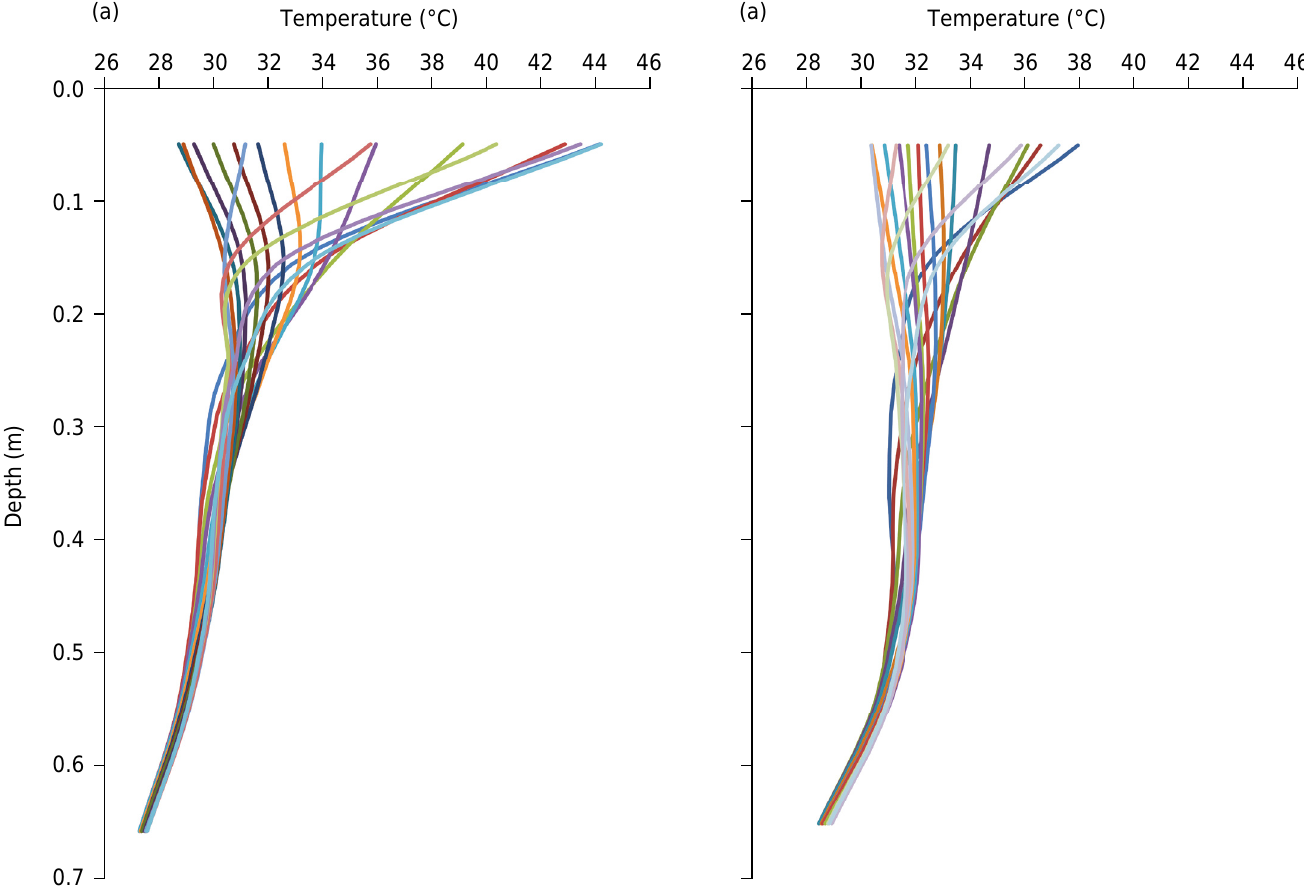
Figure 4. The geothermal profile of the soil where each line corresponds to a certain time of day. The maximum recorded depth is 0.65 m and the recorded dates are (a) April 16, 2013 and (b) August 9, 2013.